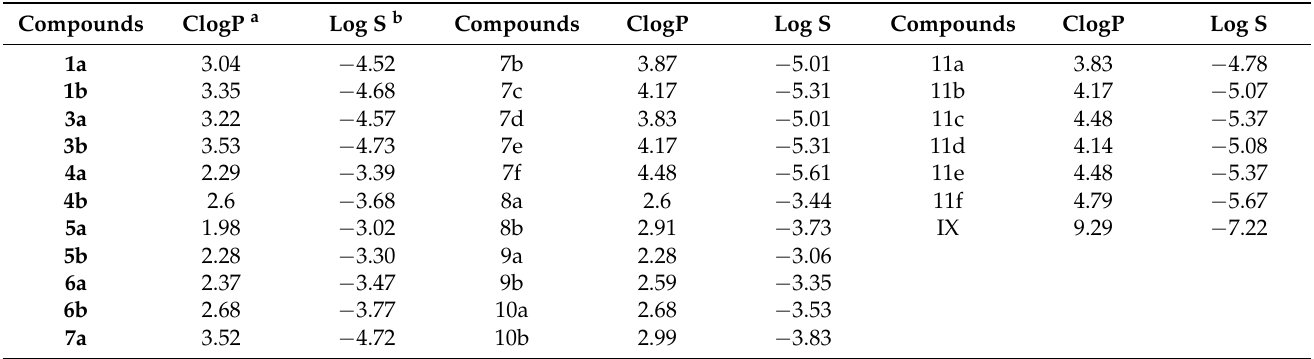
Table 4. Calculated lipophilic and solubility parameters for the synthesized compounds and the ligand compound